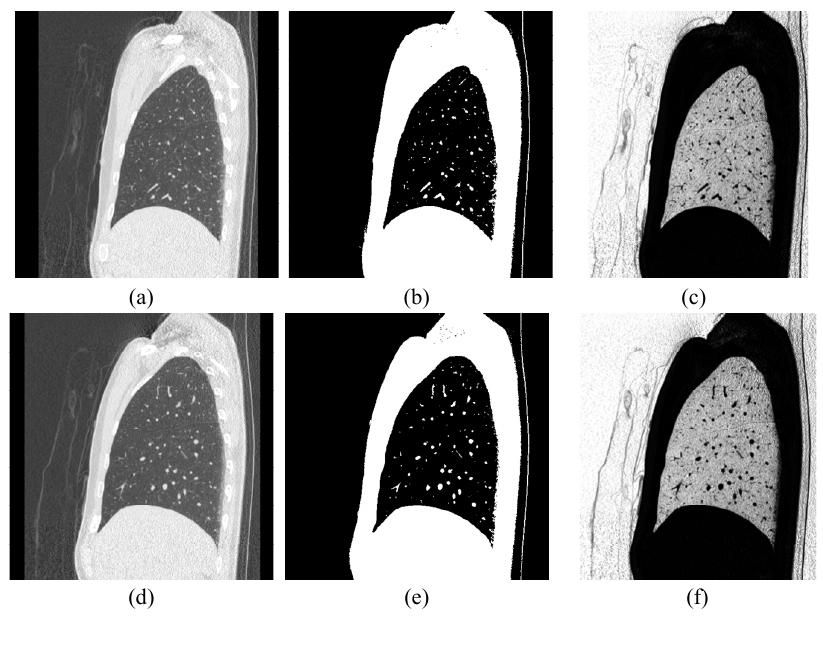
Figure 6. The examples for the definition of initial pheromone: (a,d) The sagittal view of a lung CT image; (b,e) after Otsu’s method; (c,f) after intensity